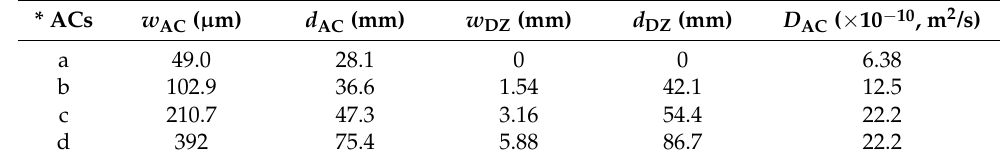
Table 1. The width and depth of ACs, DZs and the diffusion coefficient ( D AC ) of chloride ions in different ACs. The width and depth of ACs/DZs are denoted by w AC / w DZ and d AC / d DZ , respectively.